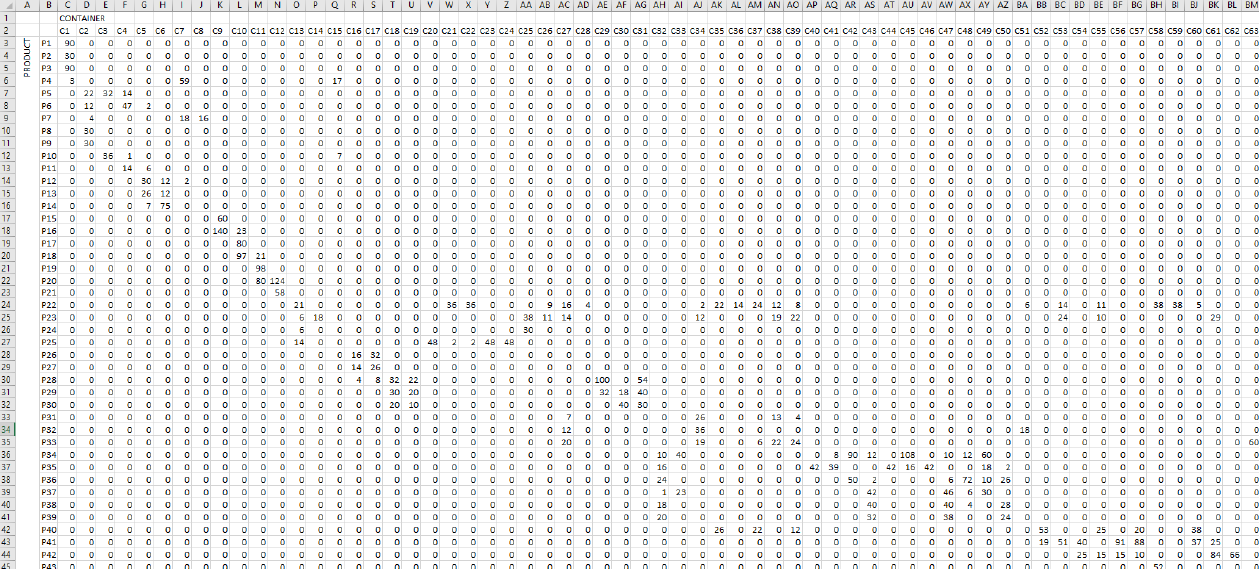
Figure 4. Quantity of products inside containers, Case 1, in the form of an Excel spreadsheet.